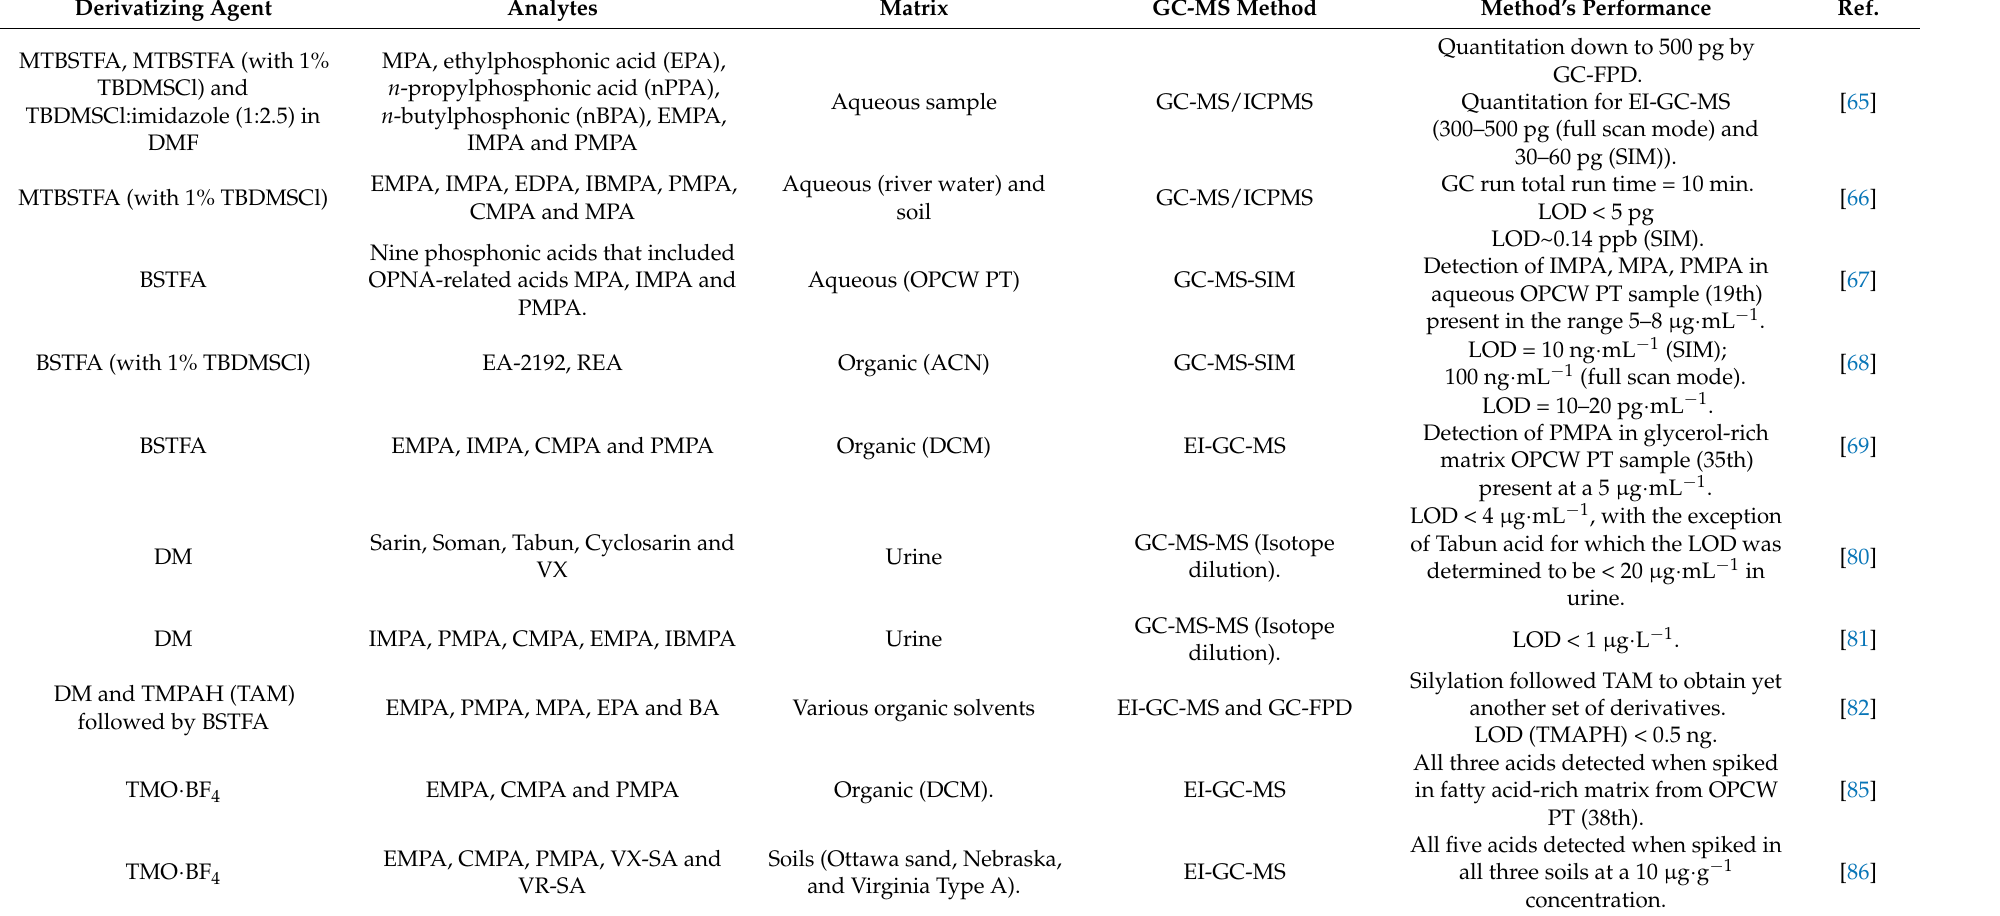
Table 1. Summary of derivatization methods for phosphonic acids related to OPNAs discussed in this